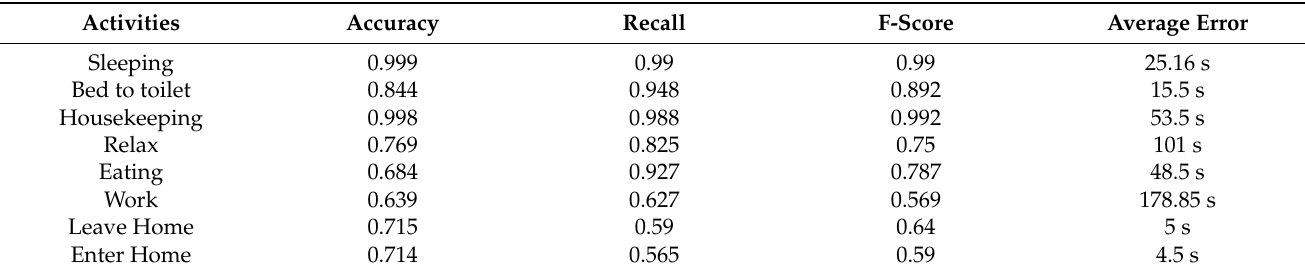
Table 7. Activities recognition performance evaluation on 5 November